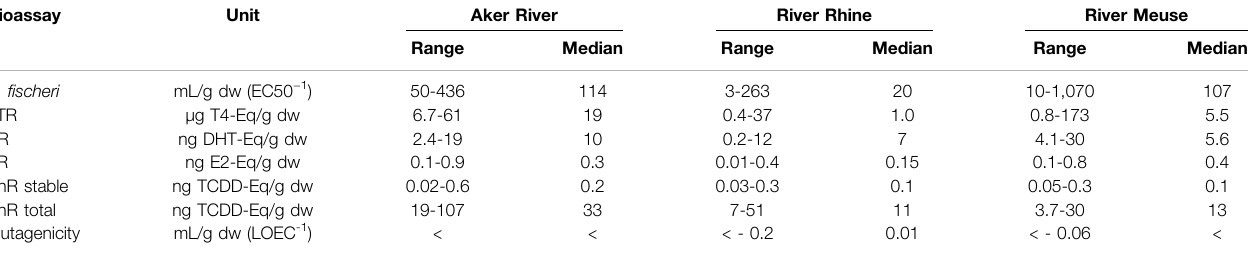
TABLE 2 | Toxicity response in the SPM samples from Aker River (n (cid:1) 6) compared with values from Hamers et al. (2015), river Rhine (n (cid:1) 19), river Meuse (n (cid:1) 12).